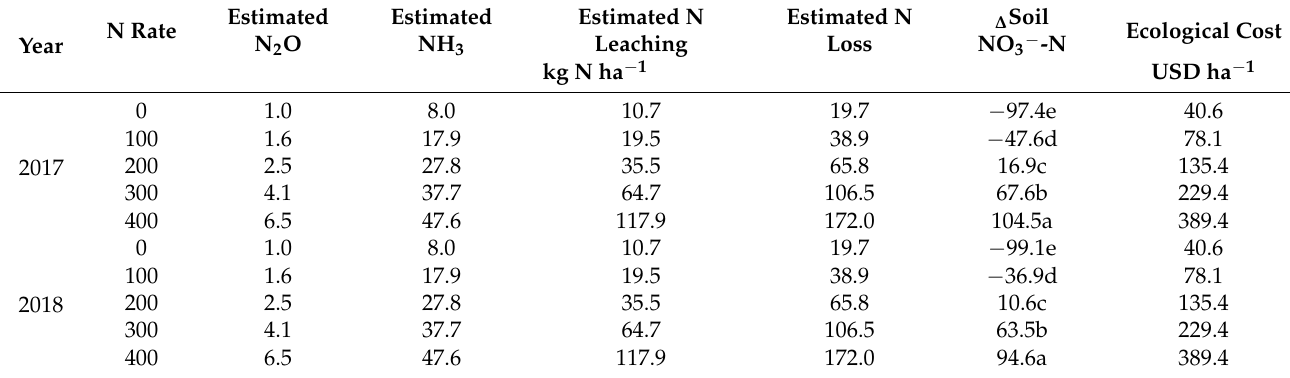
Table 2. The estimated N loss, ∆ Soil NO 3 − -N and ecological cost in 2017 and